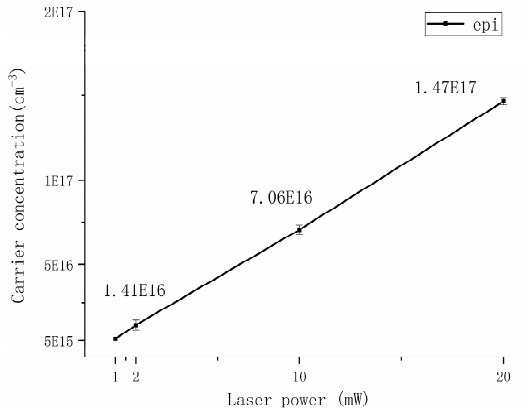
Figure 8. Linear relationship of carrier concentration of the 4H-SiC epi sample with laser power under the exciting line at 325 nm.